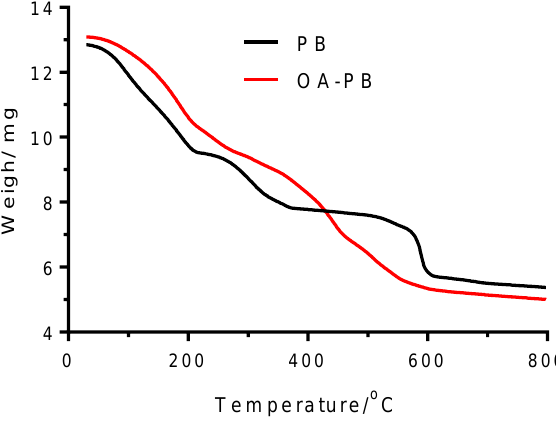
Figure 3. Thermogravimetric analysis of PB samples carried out in nitrogen atmosphere. Black line: Bulk PB (PB); red line: PB coated with oleylamine (OA–PB).